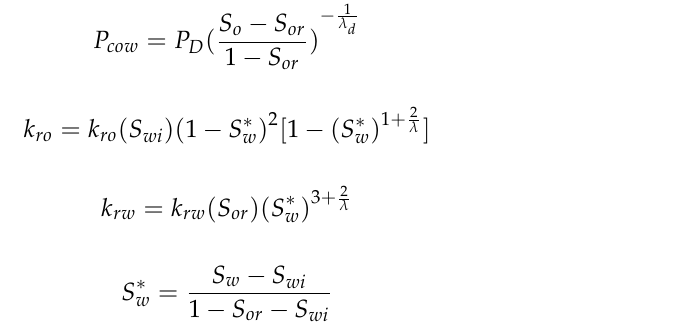
Figure 12. Upscaled absolute permeability of the single-vug model (the vug diameter is taken as 0.6 times the model length in accordance with the reference) with different values of n compared to the result obtained by Huang et al. [30] based on homogenization theory. The second numerical example is the simulation of the displacement experiment of Case 2 in Section 2.3.2 ( θ = 0 ◦ ). The following Corey-Brooks type model is adopted for the capillary pressure and relative permeability of the porous medium: